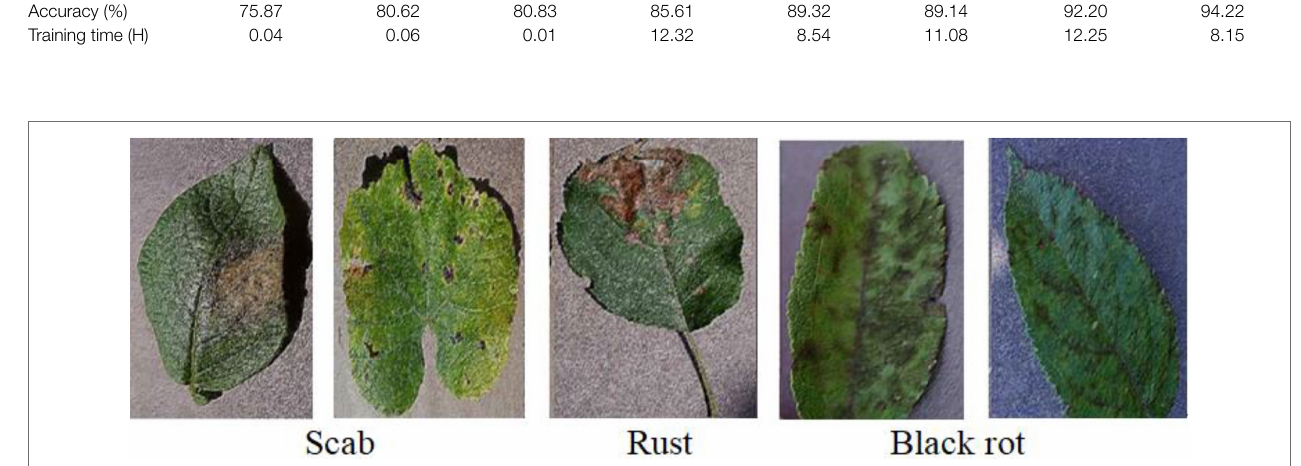
FIGURE 10 | Apple disease leaf images.